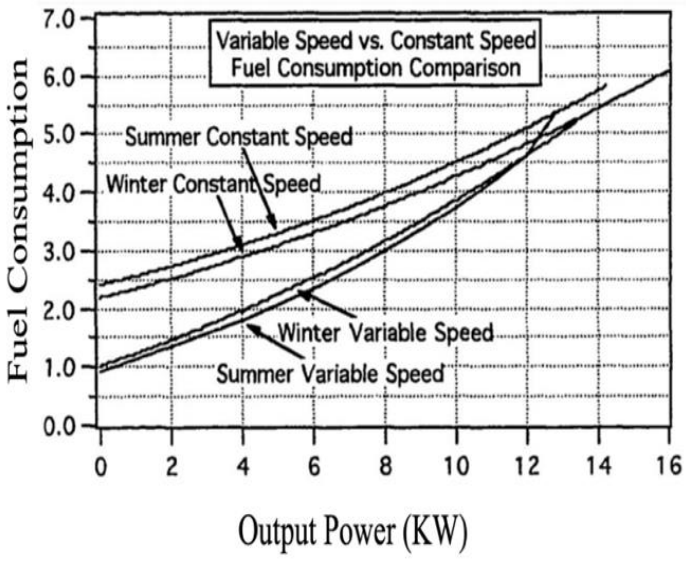
Figure 4. Comparison of different Genset applications [29] .